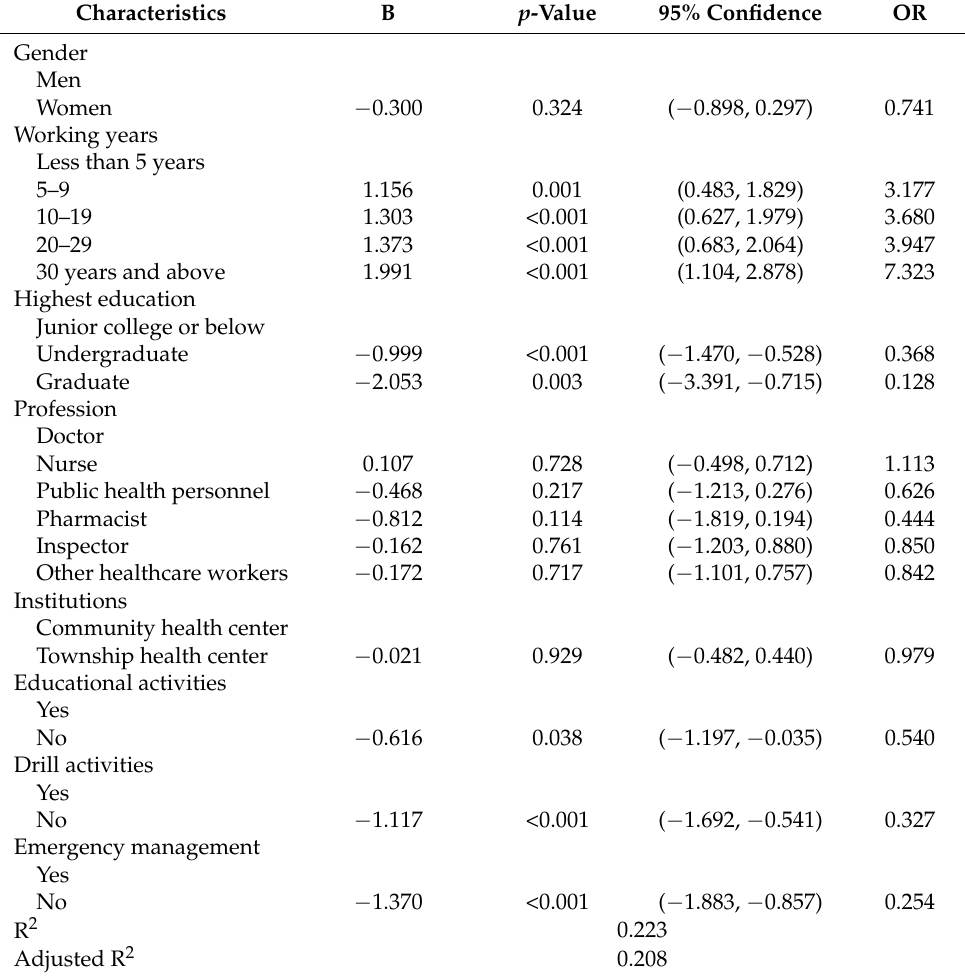
Table 5. Knowledge of healthcare workers toward PHEs and associated factors (linear regression